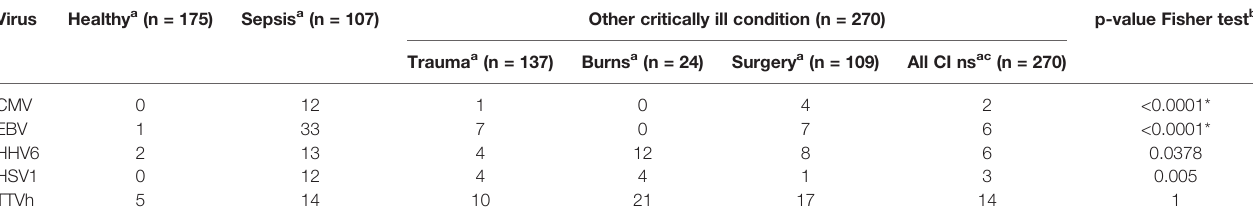
TABLE 4 | Comparative plasma DNAemia during the fi rst week following admission in sepsis patients versus a group consisting of trauma and surgery and burns patients. Virus Healthy a (n = 175) Sepsis a (n =